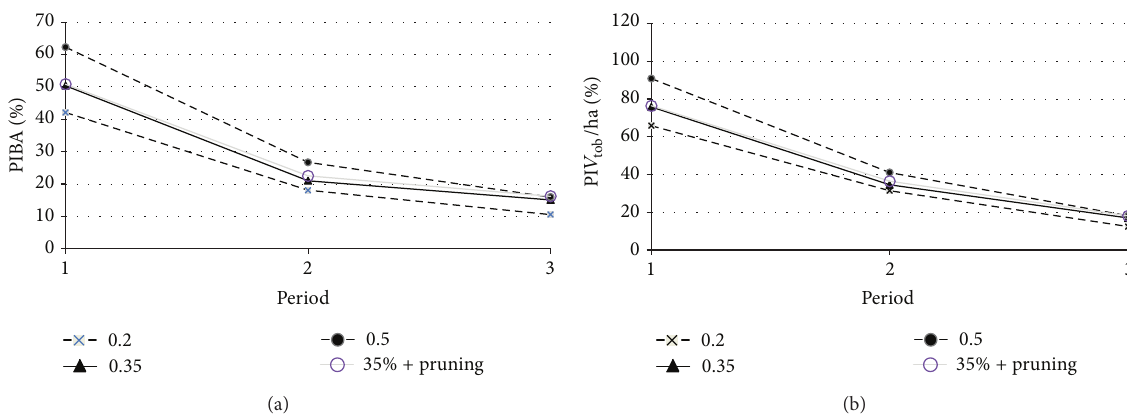
Figure 3: Percentage basal area growth (%PIBA) and percentage volume per hectare outside bark growth (% 𝑉 studied for the Bonfim